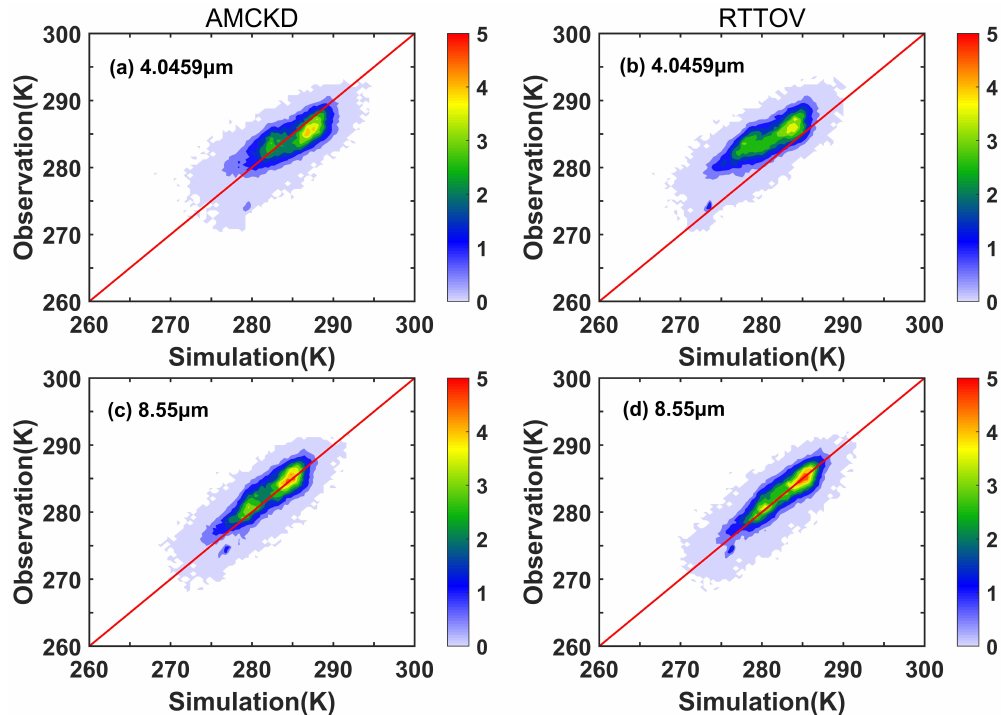
Figure 6. The joint probability distribution function (PDF) (‰) of simulated brightness temperature by AMCKD ( a , c ) and RTTOV ( b , d ) and observations of MERSI for the 4.0459 μm ( a , b ) and 10.7139 μm ( c , d ) channels with a clear sky.